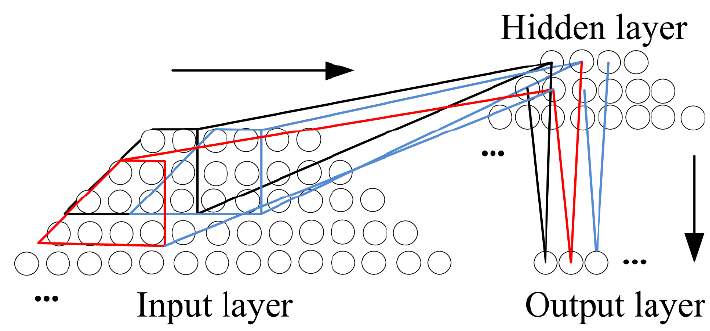
Figure 9. The feature extraction process of a neural network.